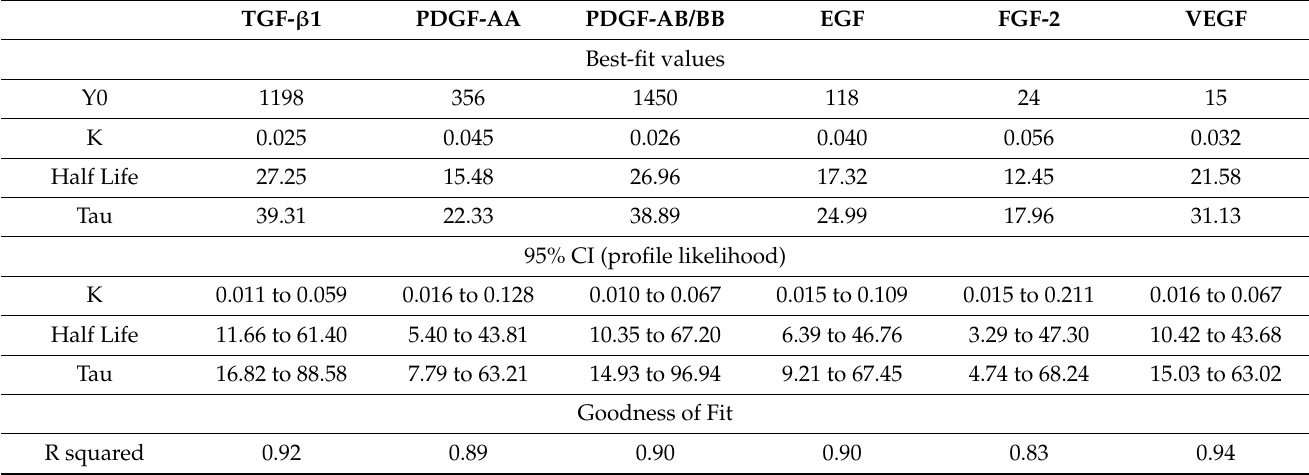
Figure 6. One-phase exponential decay of GFs in vitro and ex vivo. The figure shows one-phase exponential decay of ( A ) TGF- β 1, ( B ) PDGF-AA, ( C ) PDGF-AB/BB, ( D ) EGF, ( E ) FGF-2, and ( F ) VEGF in vitro (blue) and ex vivo (red). Significant differences in half-life times were observed for PDGF-AA ( p = 0.004), PDGF-AB/BB ( p = 0.028), and VEGF ( p = 0.033) between the in vitro and ex vivo cases. [R]: rate of release; t 1/2 : half-life time. Table 4. Best-fit values, 95% CIs, and goodness of fits of the exponential decay of each growth factor in vitro.